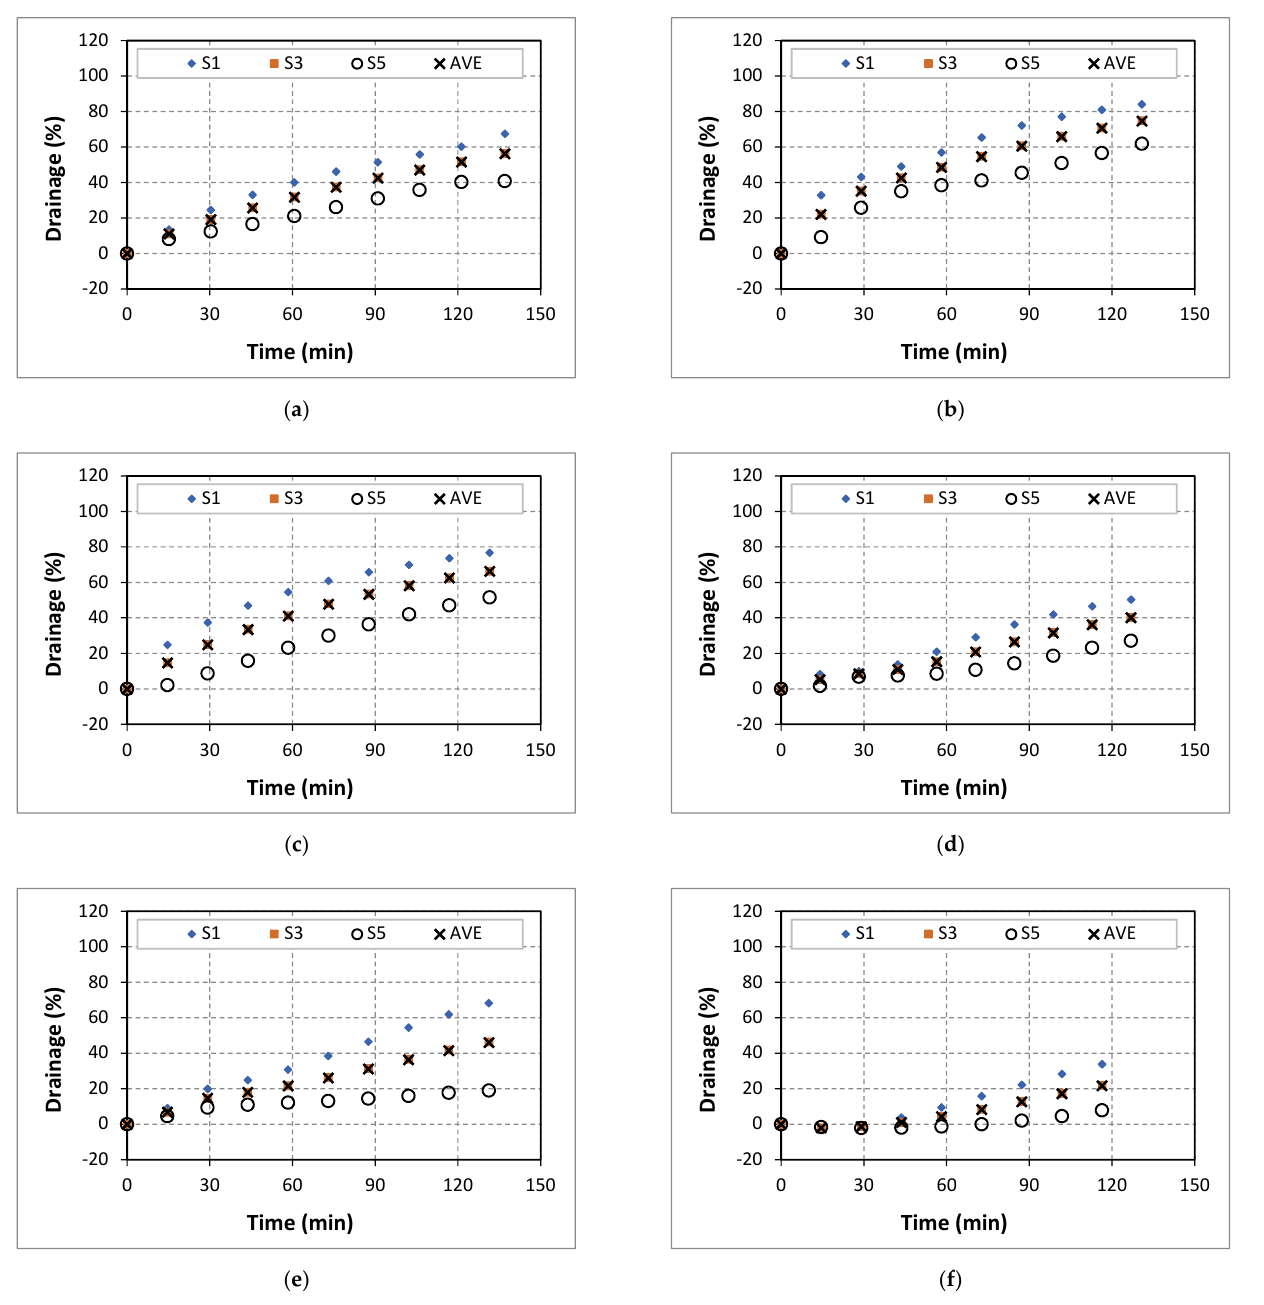
Figure A1. Drainage of 50% quality aqueous foam at different NaCl concentrations: ( a ) 0% wt., ( b ) 5% wt., ( c ) 7% wt., ( d ) 9% wt., ( e ) 14% wt., and ( f ) 18% wt.